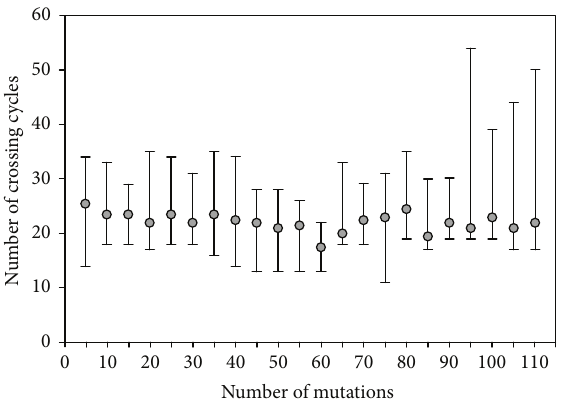
Figure 4: Relation between the threshold number of crossover cycles and number of mutated genes in offspring population; each population has a total number of 330 genes. Grey circles represent the average threshold number of crossover cycles among the 10 repeated calculations; black bars denote the scattering of 10 repeated calculations.